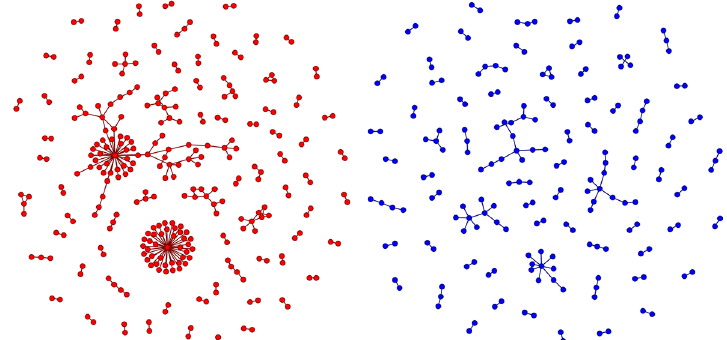
Fig. 3 The communication networks for two days with similar numbers of created users: 6 January 2020 (left), a burst day, and 24 April 2020 (right), a non-burst day. Not shown are 16,261 users from 6 January